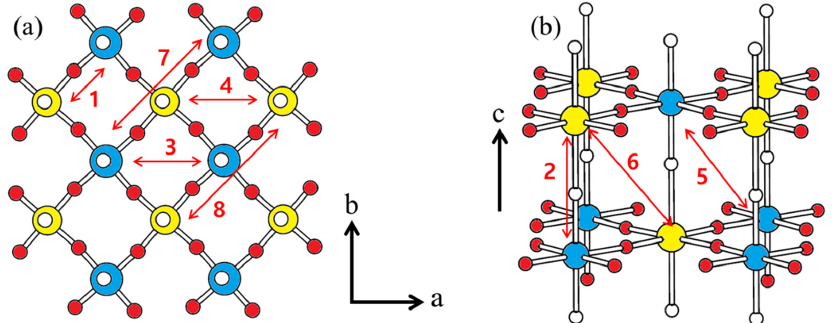
Figure 2. The considered spin exchange paths J 1 – J 8 of the Ba 2 CuOsO 6 : ( a ) projection view of an isolated ∥ ab layer of corner-sharing CuO 6 and OsO 6 octahedrons, in which the Cu-O-Os linkage is bent. ( b ) Perspective view of two ∥ ab layers of corner-sharing CuO 6 and OsO 6 octahedrons. The blue, yellow, red, and white circles represent the Cu, Os, O eq , and O ax atoms, respectively. Red arrows with 1–8 numbering refer to spin exchange paths of J 1 –J 8 , respectively. Table 1. Geometrical parameters associated with the exchange paths J 1 – J 8 in Ba 2 CuOsO 6 ; distance